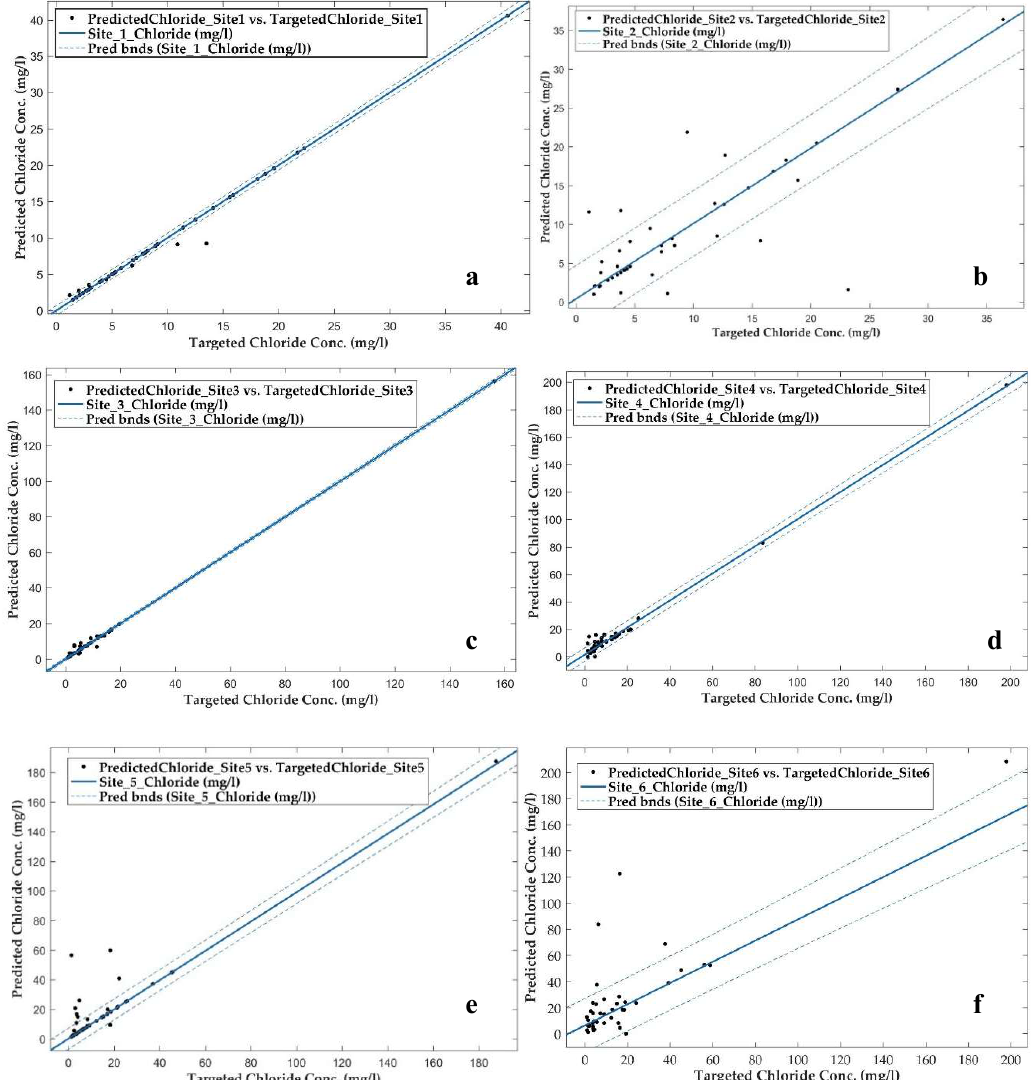
Figure 6. Curve fitting assessment between ANN output and target data of six di ff erent sites. ( a ) Site 1, ( b ) Site 2, ( c ) Site 3, ( d ) Site 4, ( e ) Site 5, and ( f ) Site 6. Site 1, 3, 4 an 5 showed the similar trend and data were not scattered. On the other hand, site 2 and 6 has scattered data point but 80% of dataset were in the confidence interval.